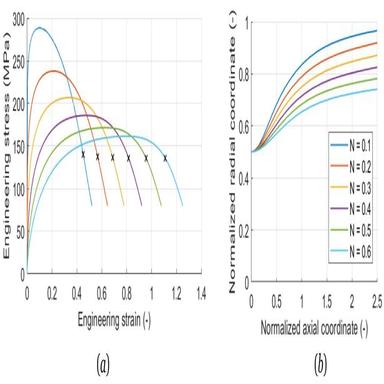
Effect of a different exponent N of the power law plasticity model on the engineering curves (a) and on the specimen profiles (b). The profiles refer to deformed configurations that are characterized by the same minimum cross section and are marked with a cross in (a). The coordinates are normalized with respect to the initial radius.q: